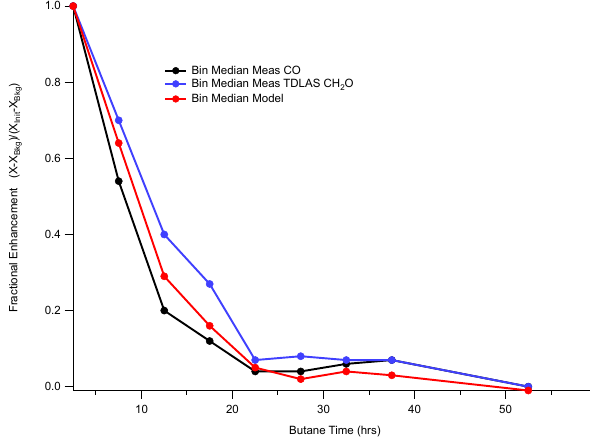
Fig. 13. Fractional enhancement for CH 2 O TDLAS measurements, box model values as well as CO observations as a function of the butane time employing a constant diurnally averaged OH concentra- tion of 3 × 10 6 molecules cm − 3 based upon Perring et al. (2010). The fractional enhancements were determined from Eq. (1) in the